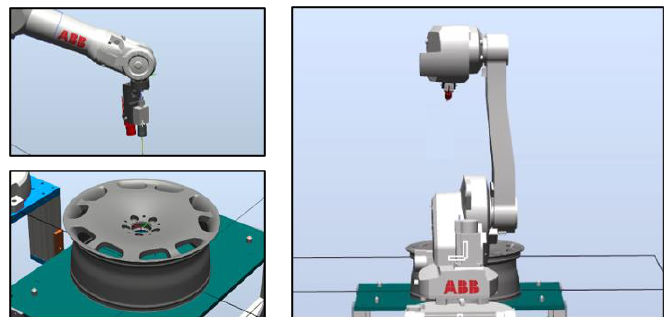
Figure 4. Environment layout.